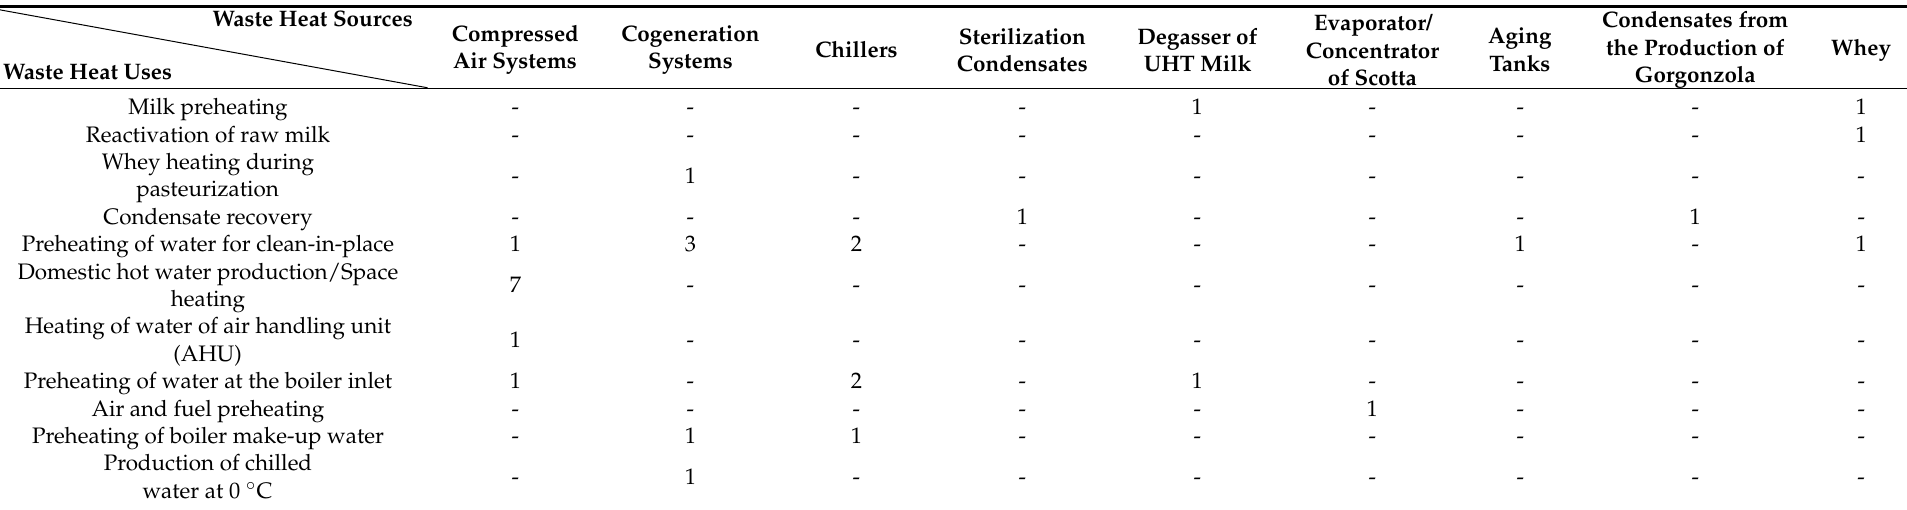
Table 3. Uses of waste heat depending on the type of waste heat recovery intervention.